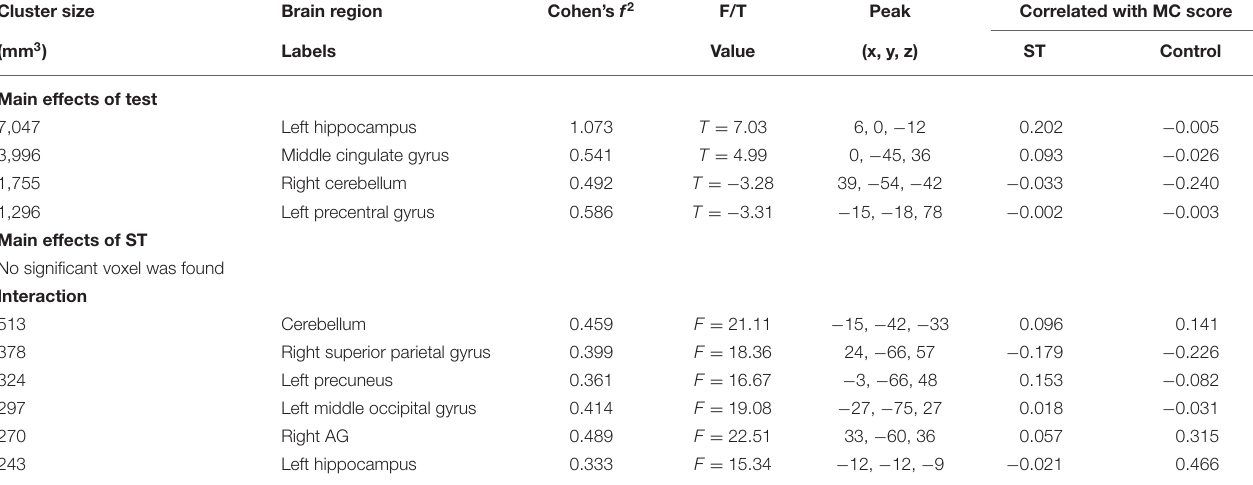
TABLE 2 | The brain regions that were significant in the mixed-effect analysis of the binary graph. Cluster size Brain